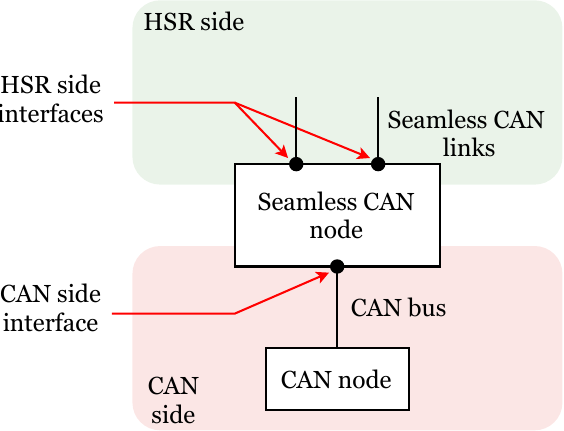
Figure 4. Three interfaces of a seamless CAN node